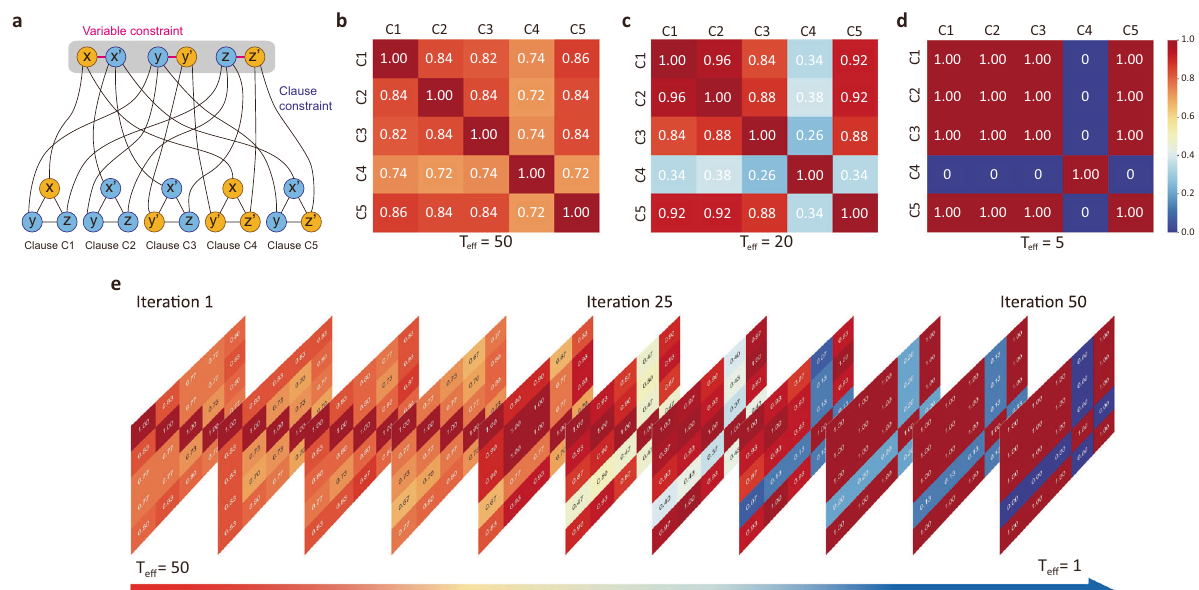
Fig. 5 Russel – Rao similarity matrix underlying the clauses employing different “ cooling ” strategy in a MAX-SAT problem. a Schematic shows that the fi ve clauses in MAX-SAT problem are correlated with each other, which is imposed by variable constraint and clause constraint. For illustration, the yellow- circled variables are assigned true values, thus making the blue-circled variables false. b c d Russel – Rao similarity matrix between the fi ve clauses when BM runs the optimization process under T eff = 50, 20, and 5, respectively. e The evolution of the Russel – Rao similarity matrix in a BM optimization process when T eff is decreased linearly with each iteration